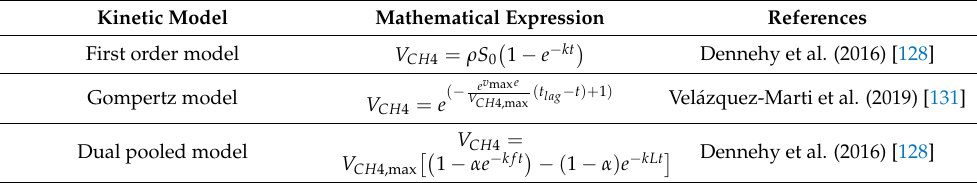
Table A1. Existing empirical models for SSAD